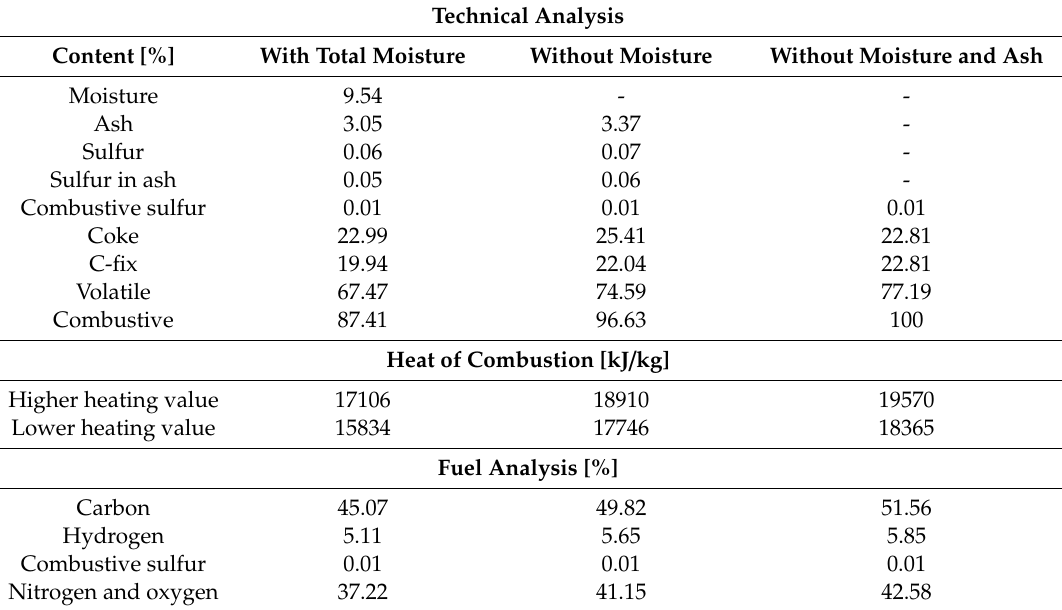
Table 1. Technical analysis of the sunflower seed shells